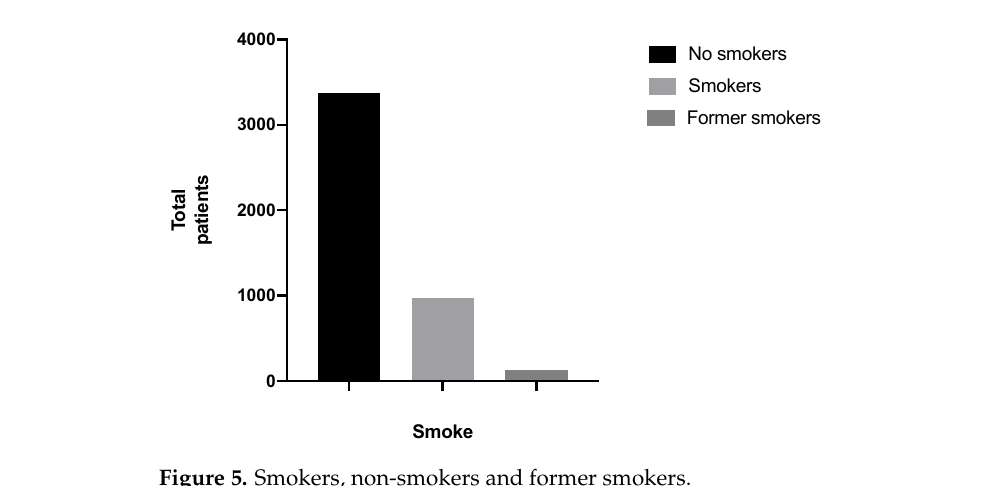
Figure 4. Distribution of systemic pathologies in patients. Among 4487 patients, there were smokers, non-smokers and ex-smokers, respectively, 973 (21.68%), 3377 (75.26%) and 133 (2.96%). The remaining four patients did not report these data in the medical record (0.09%) (Figure 5).